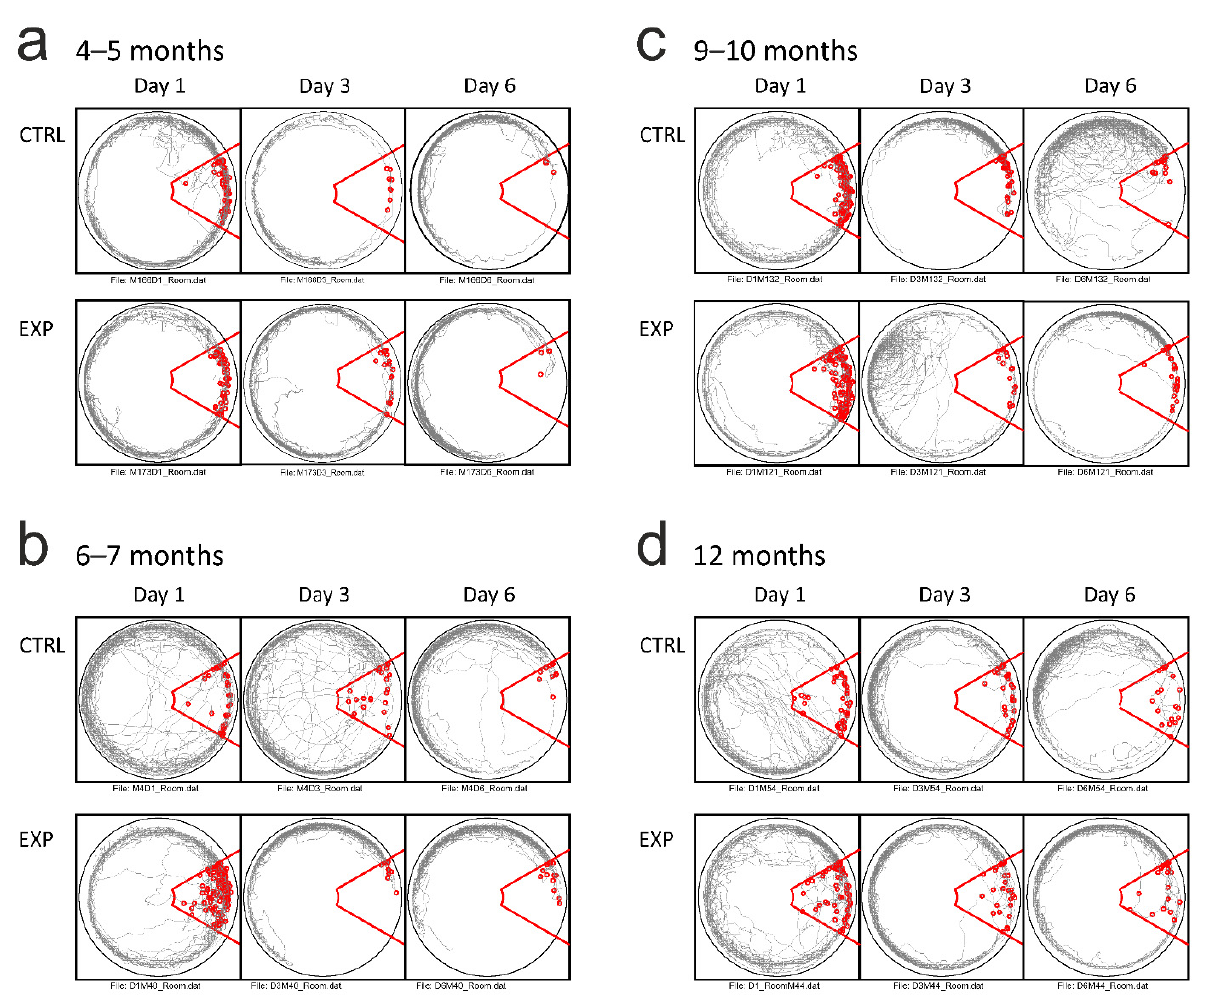
Figure 3. Examples AAPA tracks (grey line) from pairs of experimental and control animals across days 1, 3 and 6 from all age groups. The tracks are depicted in the room coordinate frame. As in Figure 1d, the red line indicates the boundaries of the punished area, with red circles marking the individual footshock’s delivery. Note the evolution of an avoidance behaviour during the course of the training across all age groups: ( a ) 4–5 months, ( b ) 6–7 months, ( c ) 9–10 months and ( d ) 12 months.